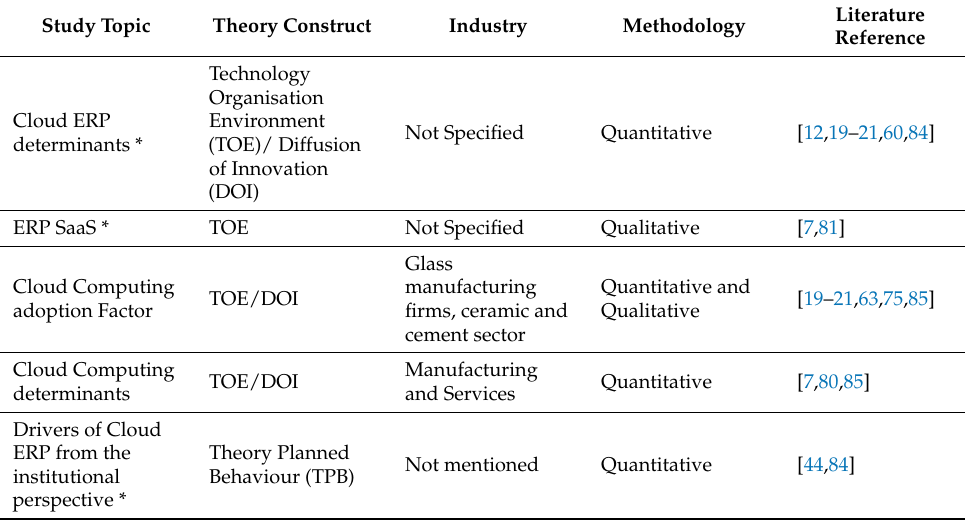
Table 3. Cloud ERP (C-ERP) adoption factors in theories and